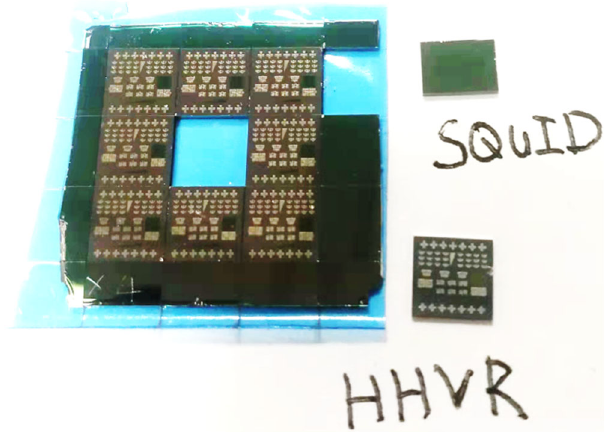
Fig. 5 | Photo ofa Pt 0.75 Ti 0.25 /Fe x Tb 1- x sample separated into pieces by a dicing saw. The patterned pieces are used for HHVR measurements and un-patterned regions for SQUID measurements. The “ SQUID ” pieces underwent the same pro- cessing as the Hall bars during the device fabrication, providing good consistency between the electrical and magnetic properties of the samples in our